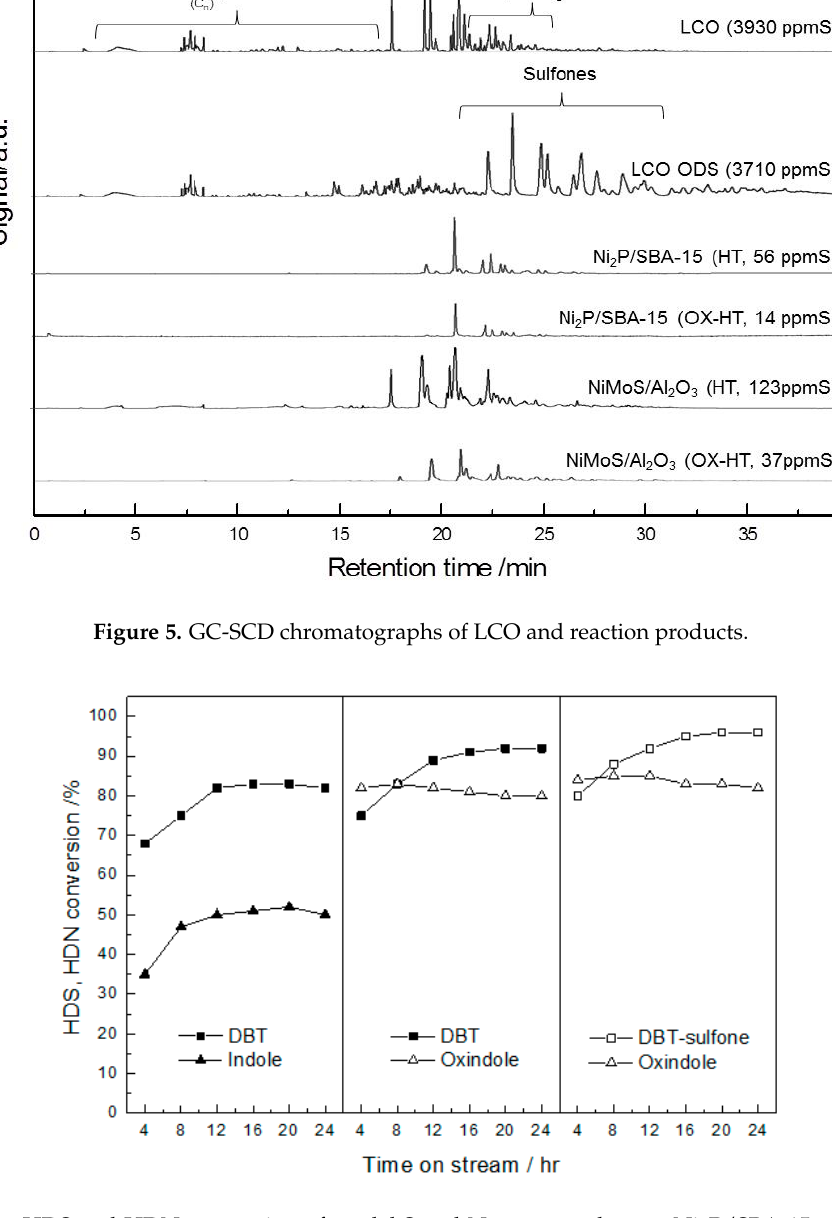
Figure 6. HDS and HDN conversion of model S and N compounds over Ni 2 P/SBA ‐ 15 catalyst at 3.0 MPa and 623 K.